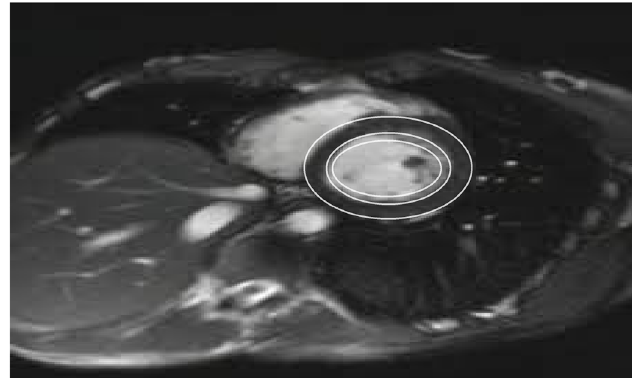
Fig. 7. Segmentation of an image of the heart taken by an